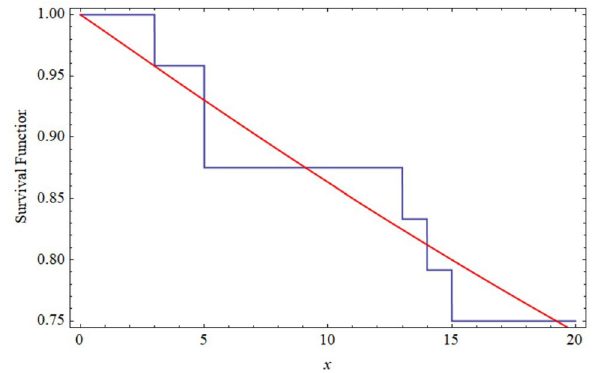
Figure 9. The Empirical and fitted survival functions for the first sample of real data.